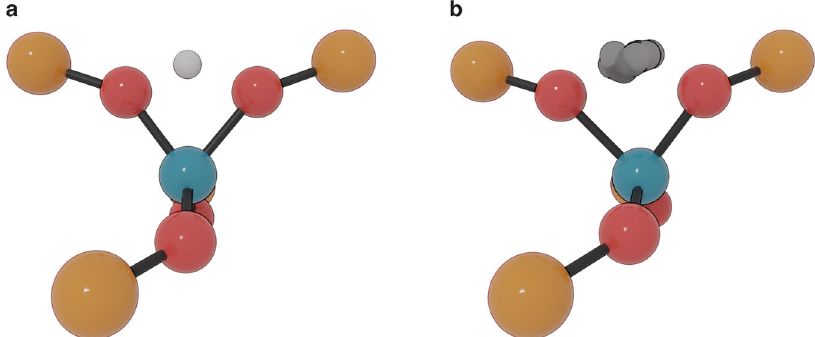
Fig. 5 | The use of PIMD leads to a signi fi cant spread in the proton location. Thesetwosnapshots,arbitrarilyextractedfromthetransitionstateumbrellaofthe 2 – 3 hopping, highlight how the system beads in PIMD ( b ) can be spread quite signi fi cantly in space with respect to the classical case ( a ). For the sake of clarity,